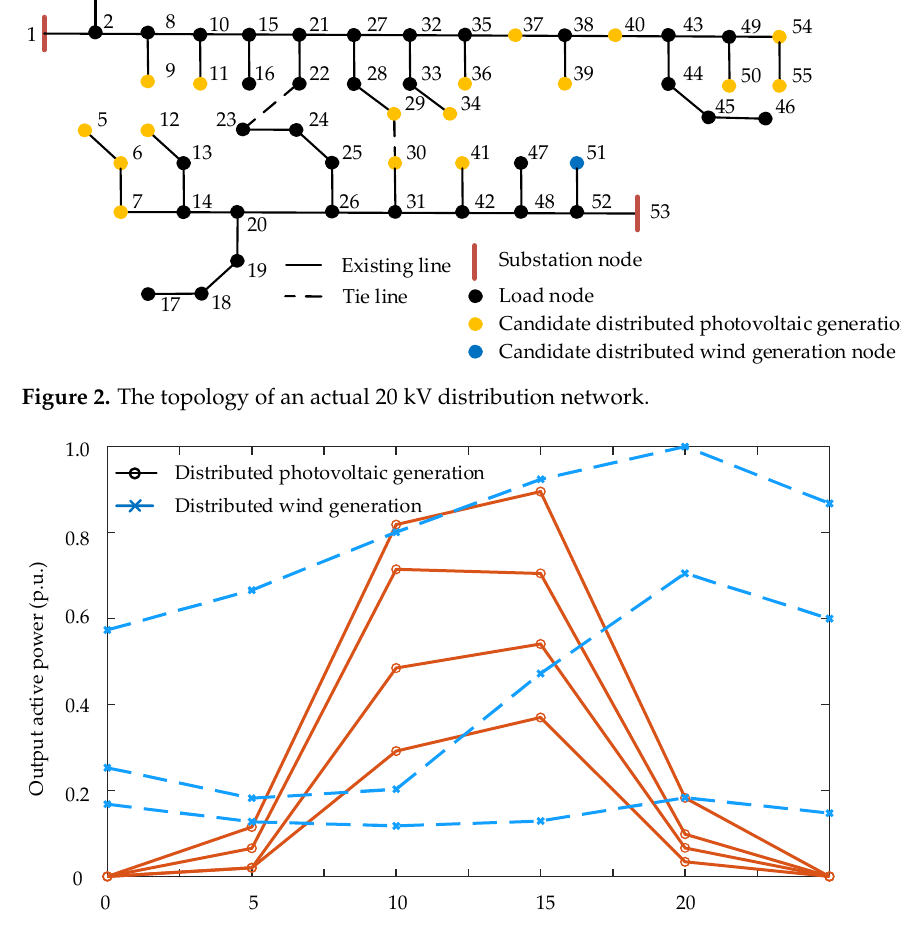
Figure 3. The output curves of distributed photovoltaic generation and distributed wind generation. The population size of improved NSGA-II is set to 100, the number of iterations to 100, the crossover probability to 0.7 and the mutation probability to 0.3. The change in the number of Pareto frontier solutions with the number of iterations is shown in Figure 4. It can be seen from Figure 4 that the improved NSGA-II can converge when iterating 26 boundary solutions of the minimum node voltage deviation and maximum line capacity margin, the objective function value of the node voltage deviation f 2 in the optimal solution is 1.5% higher than the optimal value (i.e., the minimum value) in all Pareto frontier is 0.1% lower than the optimal value (i.e., the maximum value) in all Pareto